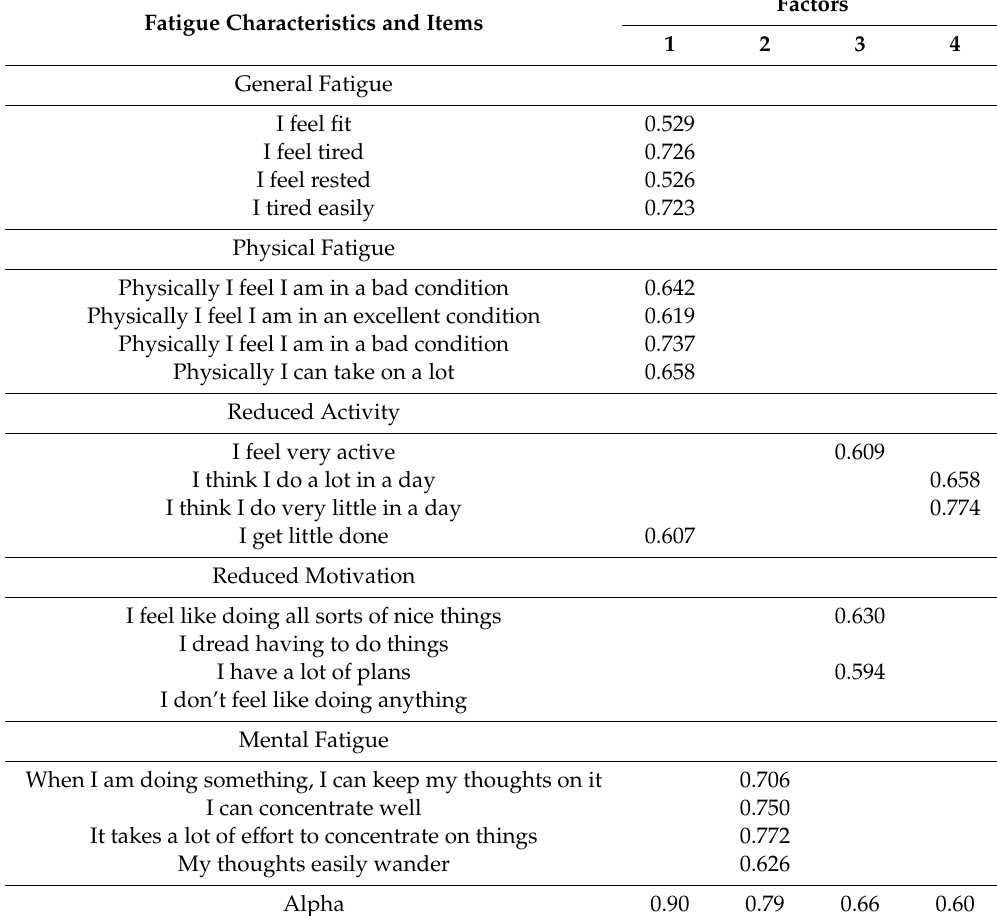
Table 4. Factor analysis of the Multidimensional Fatigue Inventory (MFI) 20-item responses.